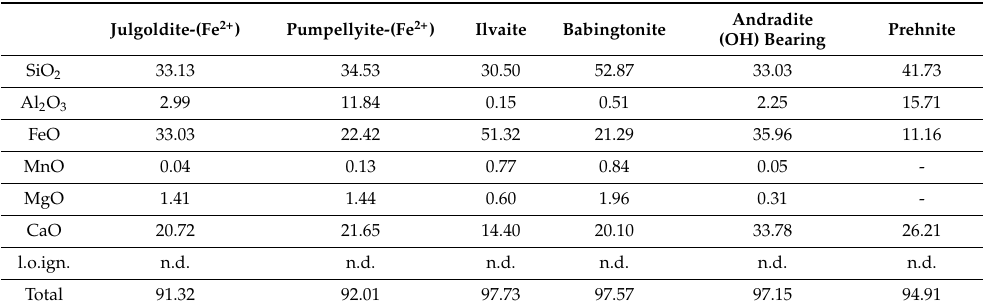
Table 5. Chemical composition (wt.%) of Ca-Fe-silicates from Salsette Island reported by Wise and Moller [39]. n.d.—not